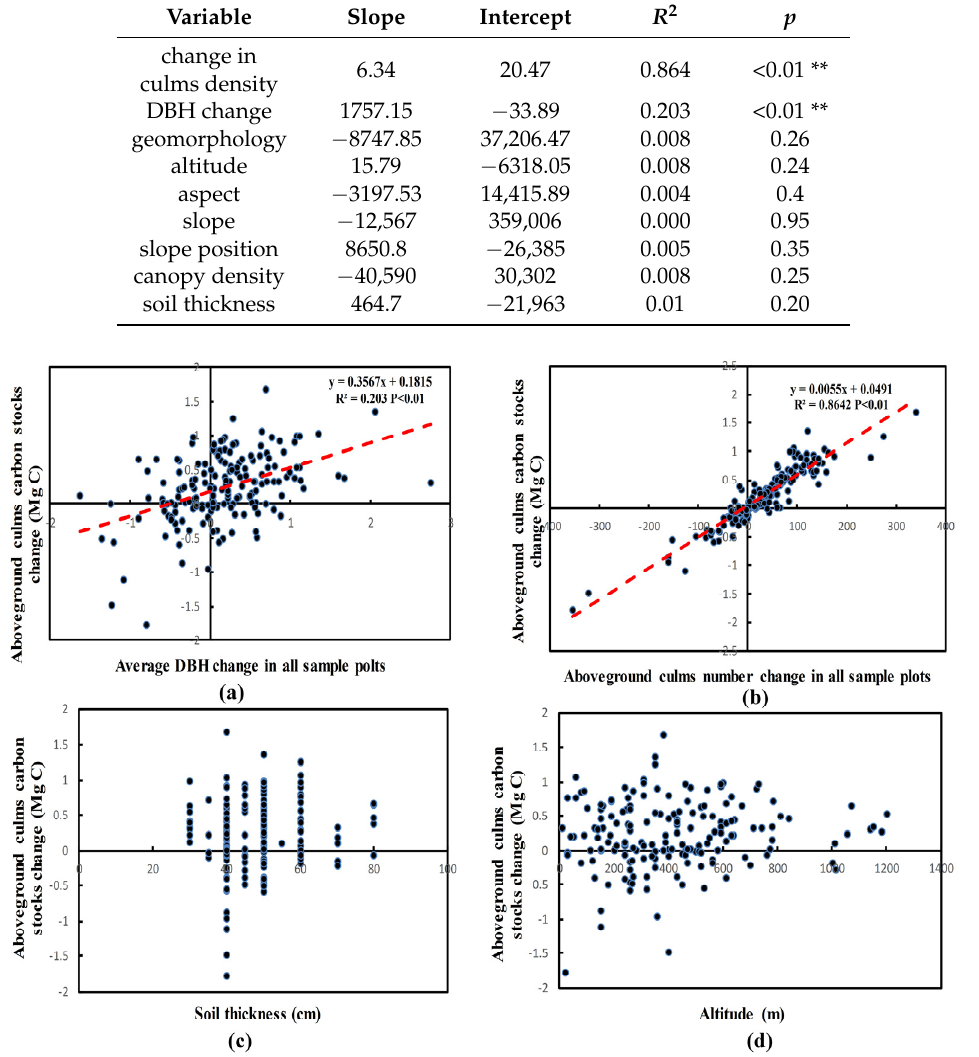
Table 1. Type II (major axis) correlations between carbon stocks change and biotic or abiotic factors. (** represents statistical significance at p < 0.01). DBH, diameter at breast height.